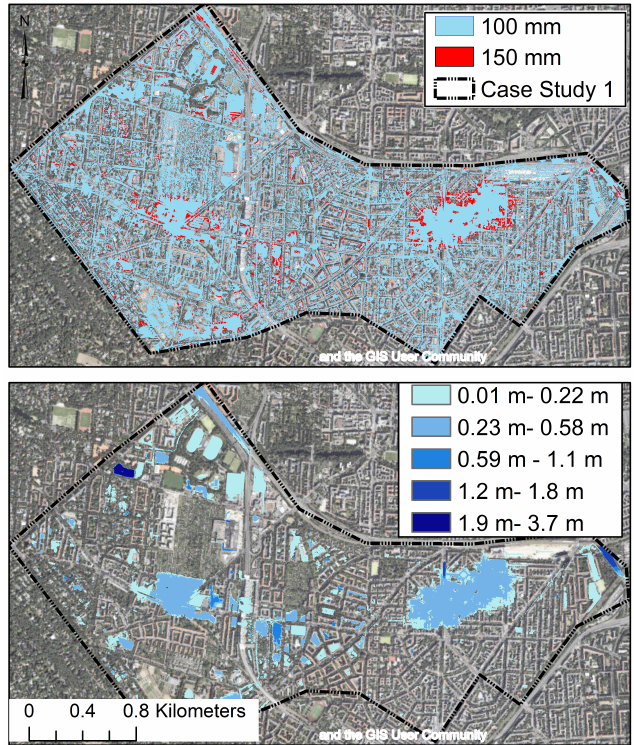
Figure 8. Inundation-extent for 100 and 150 mm precipitation depths for case study